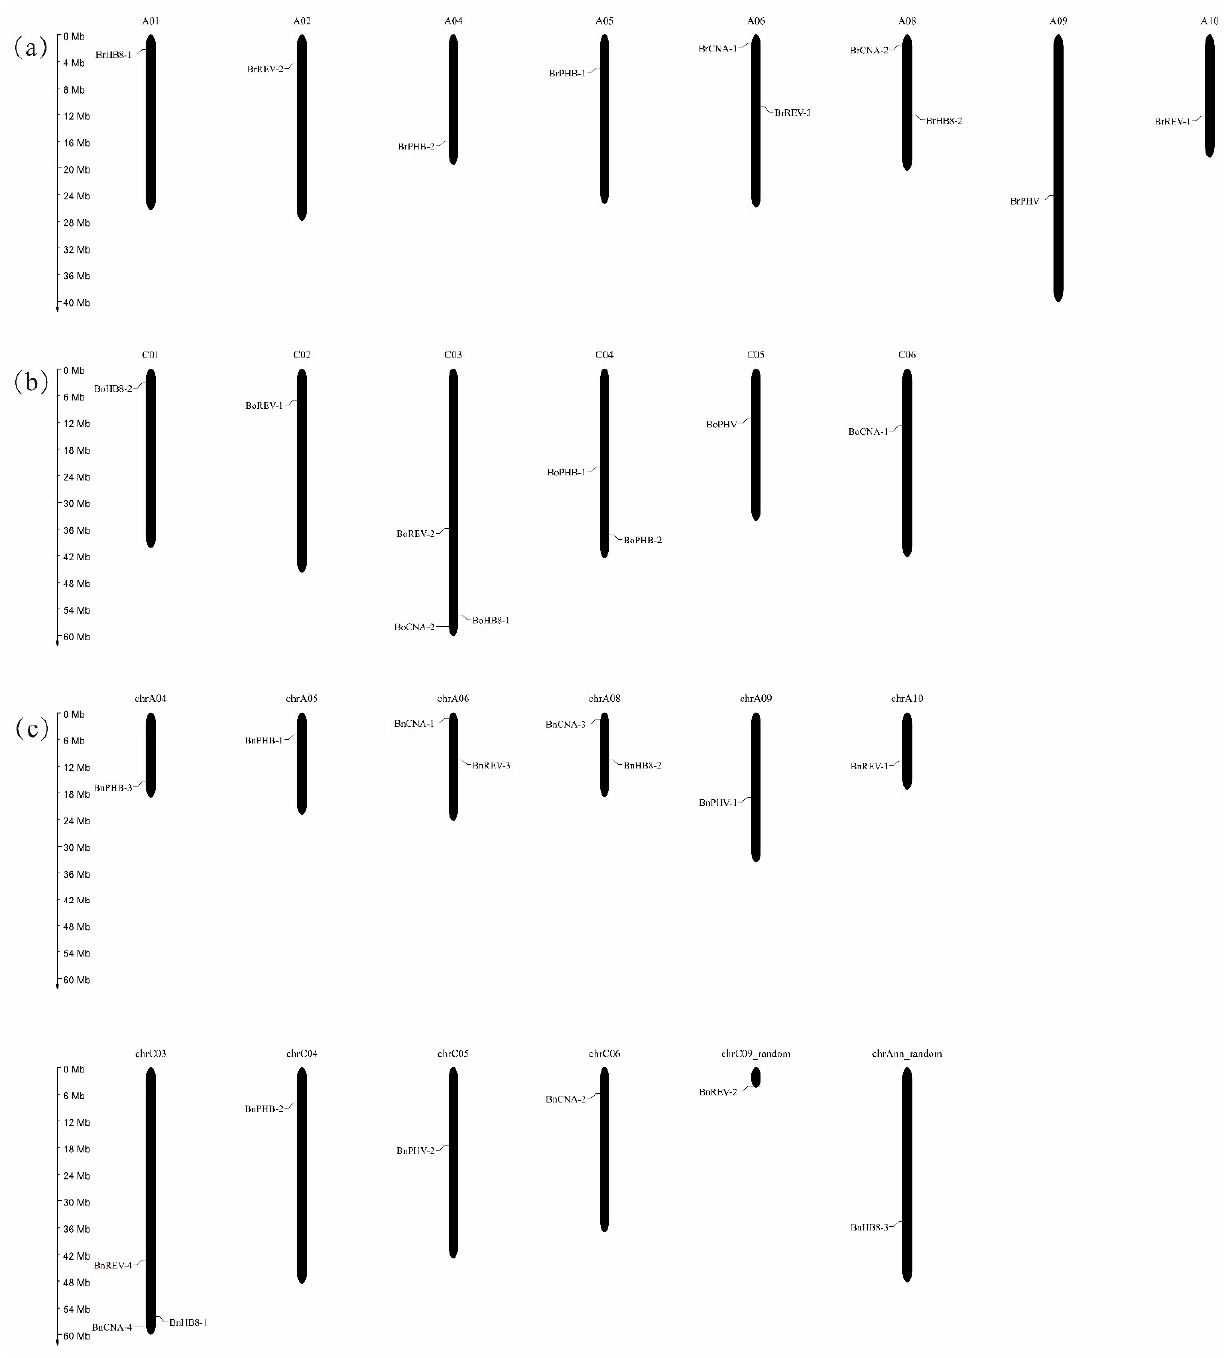
Figure 1. The chromosomal locations of HD-ZIP III genes in B. rapa ( a ), B. oleracea ( b ) and B. napus ( c ) .